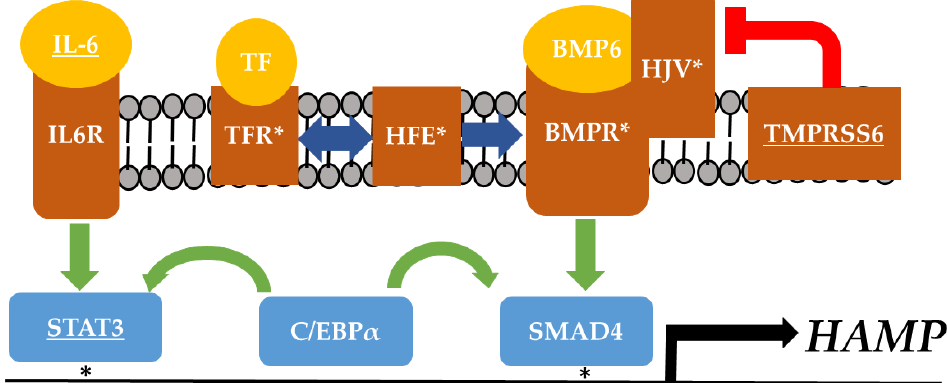
Figure 1. Hepatic hepcidin activation pathway. HAMP gene expression is activated by the IL6 and transferrin pathways, which are linked by C/EBPα. Genetic variants affecting protein function are associated with systemic iron overload (White Asterisks) and diabetes (Underlined), while variants in transcription factor binding sites in the HAMP promoter are associated with systemic iron overload (Black Asterisks). It is unknown if there are genetic variants in the HAMP pathway associated with diabetes risk during a high iron diet.